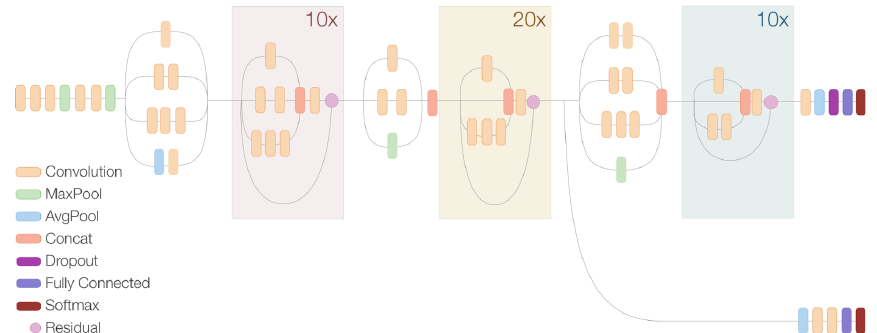
Figure 5. Faster R-CNN Inception ResNet v2 neural network